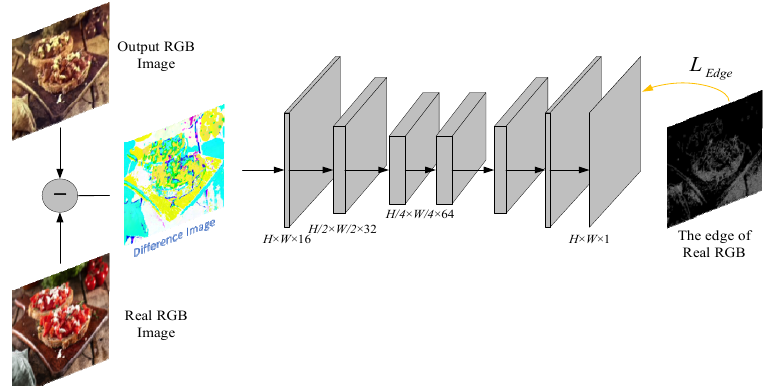
Figure 5. The edge ‐ assisted network structure. Figure 5. The edge-assisted network structure.